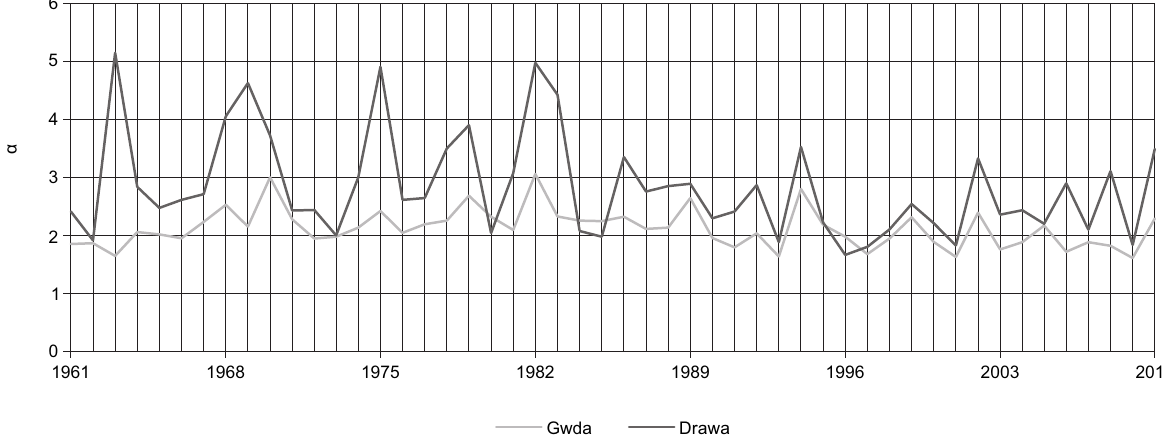
Fig. 3. Irregularity coefficient of water stages of the Gwda River in Piła and the Drawa River in Drawiny in hydrological years